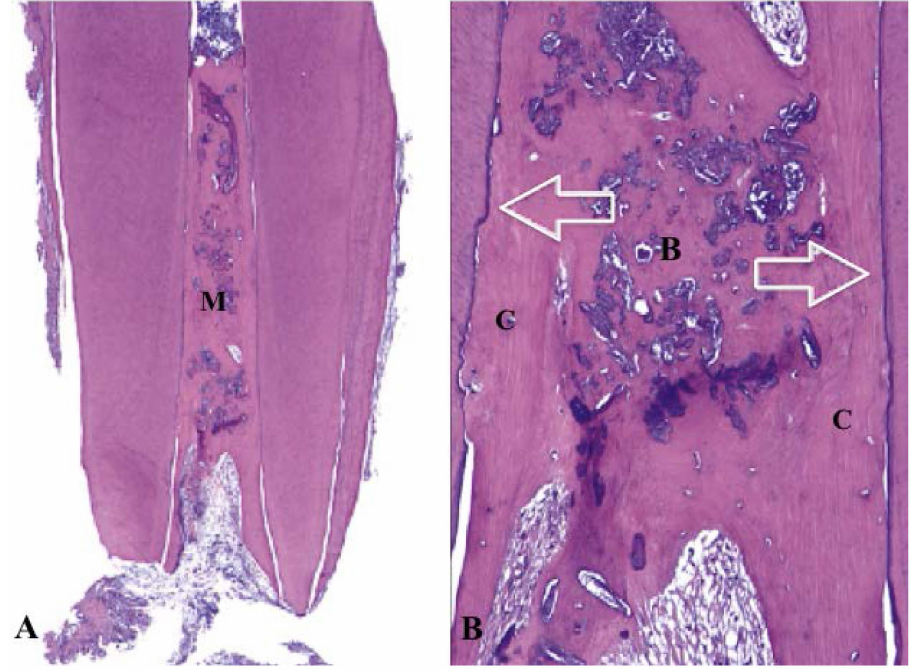
Figure 2. Histology of revascularized human immature permanent tooth (hematoxylin-eosin stain). ( A ) The canal space filled with mineralized tissue (M) (original magnification ˆ 16); ( B ) High magnification of A. The mineralized tissue similar to bone ( B ) and cementum ( C ). The canal dentin walls covered by newly formed cellular cementum-like tissue (arrows) (original magnification ˆ 100)